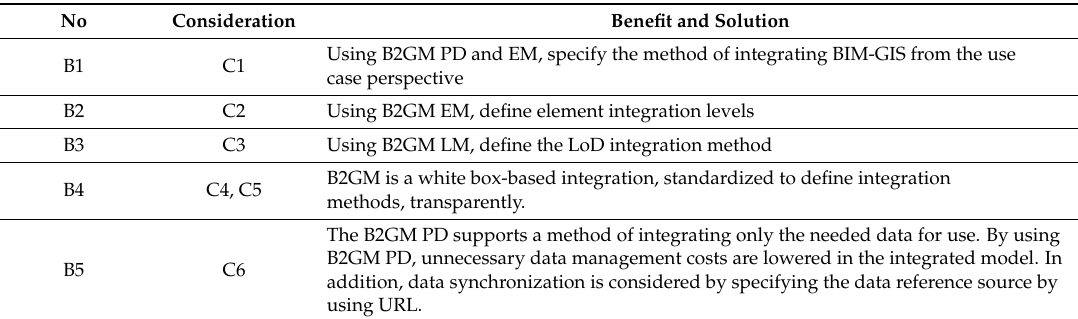
Table 8. B2GM benefits and solutions related to consideration.